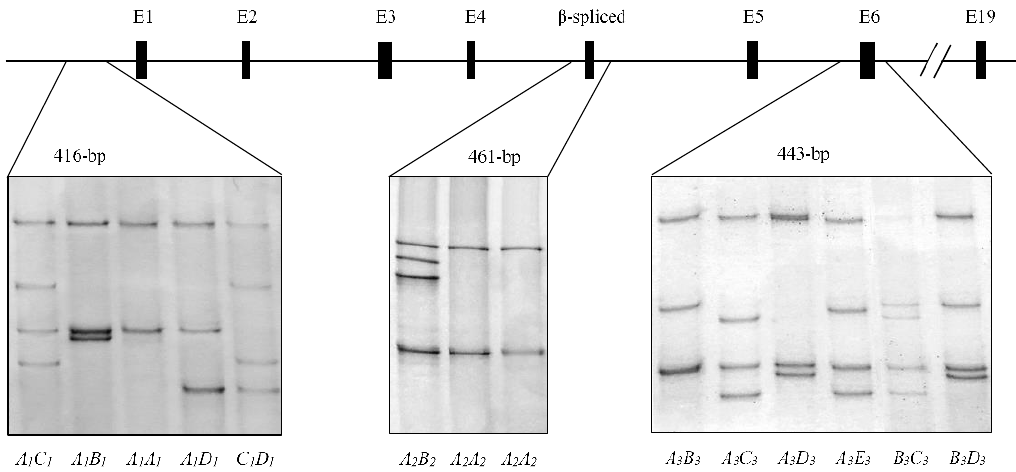
Figure 1. Sequence variation in the ovine lipin 1 gene ( LPIN1 ) identified by polymerase chain reaction-single strand conformation polymorphism (PCR-SSCP) analysis. Di ff erent SSCP banding patterns for amplicons from the three gene regions are shown in either homozygous or heterozygous forms. “E” indicates a coding exon, and “ β -spliced” indicates the alternatively spliced exon used in LPIN1β .